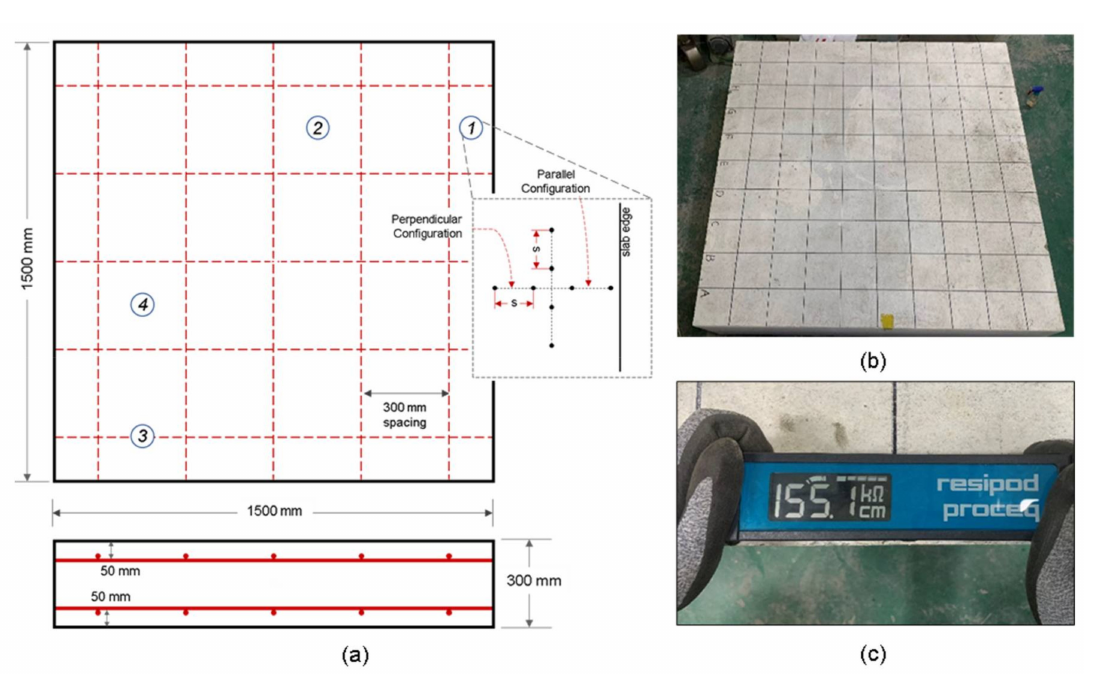
Figure 4. Experimental set-up of ER measurement in concrete slab: ( a ) schematic diagram of concrete slabs with measure- ment points; ( b ) picture of actual specimen; and ( c ) Wenner probe device orientation during ER